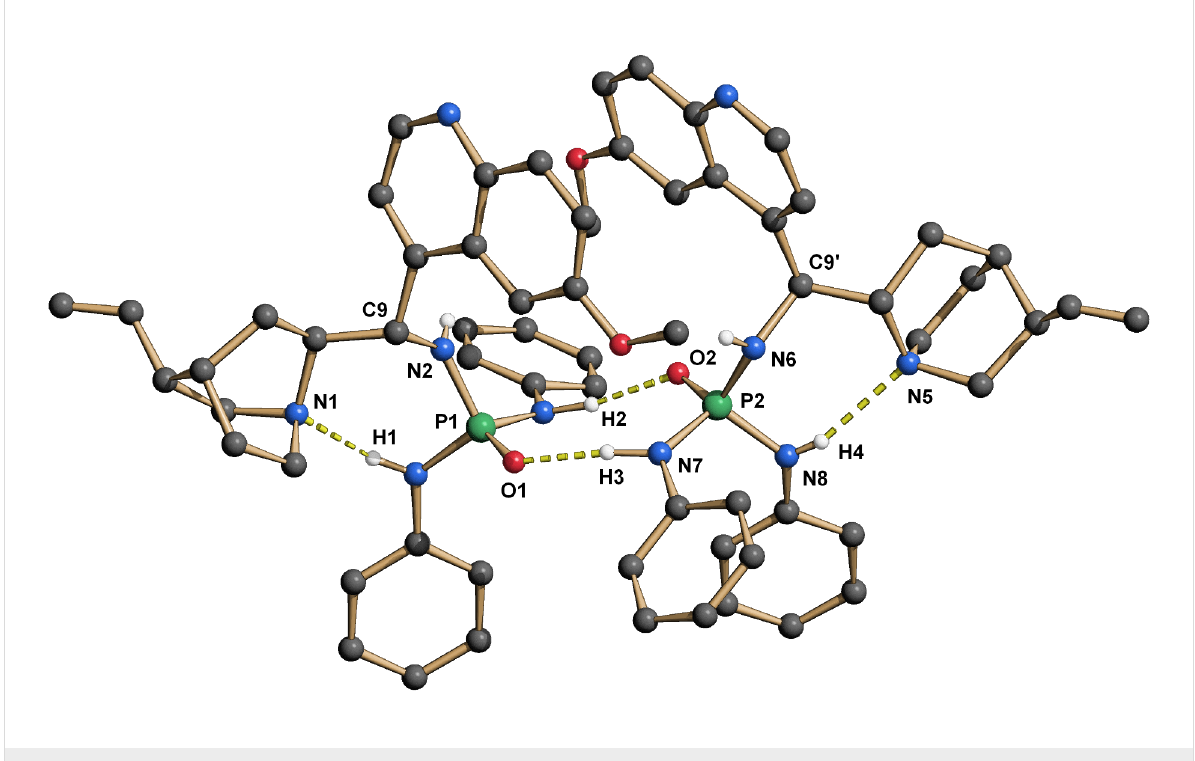
Figure 3: X-ray structure of 6 -dimer. The hydrogen atoms are omitted for clarity, except at all nitrogens.